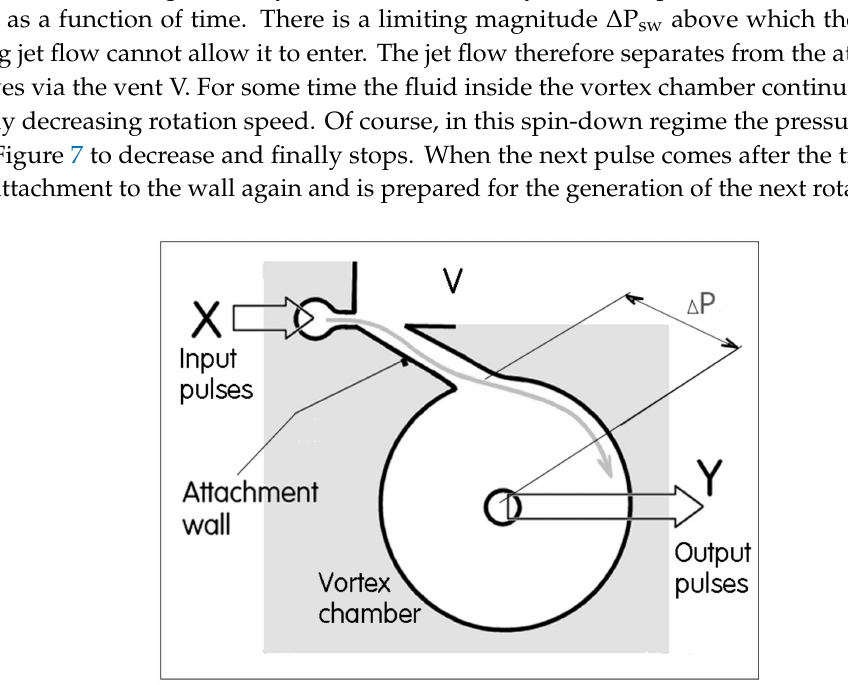
Figure 6. Planar pulse shaper with the time delay derived from starting and increasing rotation in the vortex chamber. The pulse length is determined by the time when centrifugal force can no more keep the jet attached by Coanda-e ff ect [5] at the attachment wall so that the jet is pushed away into the vent space V.